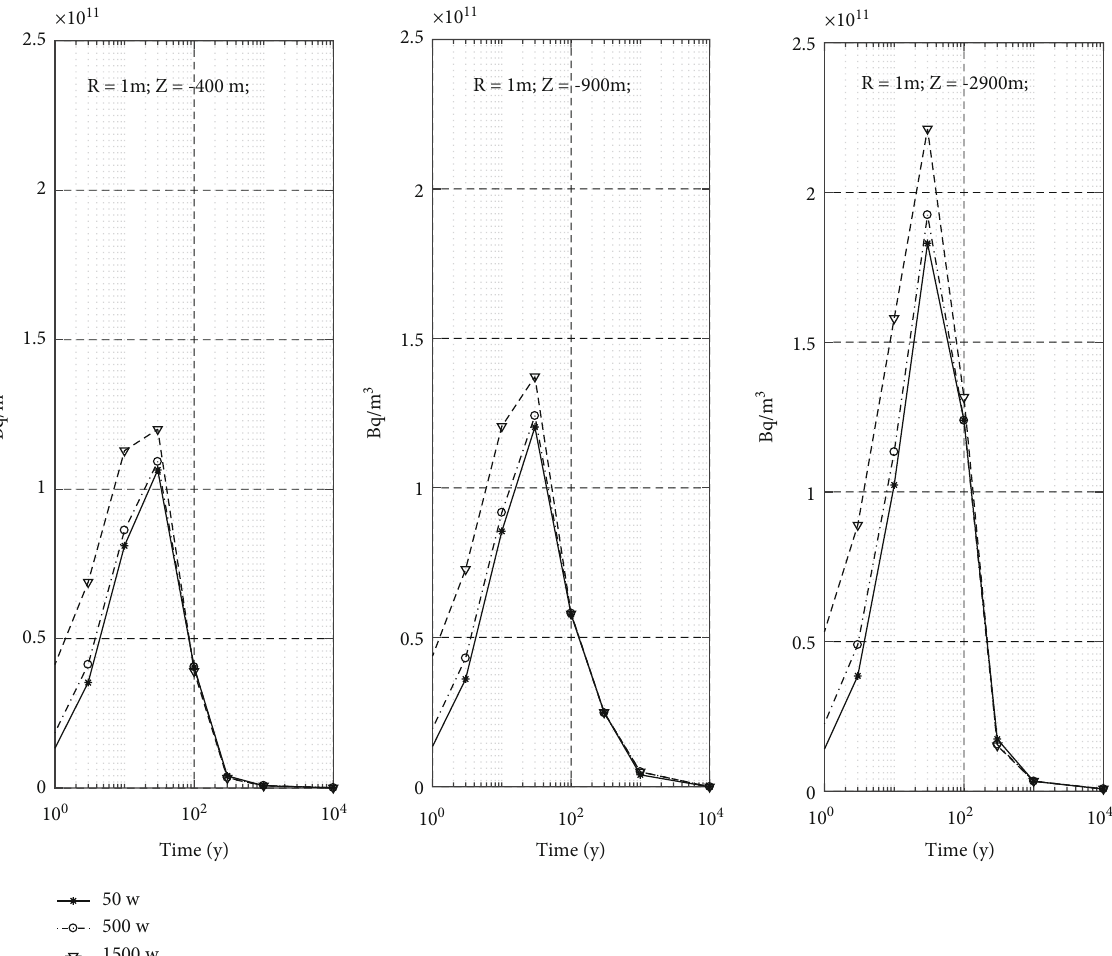
Figure 9: Total radioactivity evolution of all fi ve radionuclides observed at the midpoint of the 200m waste disposal interval and at radial distance R = 1 m as function of disposal depth ( Z = − 400 m , -900 m, and -2900 m) and heat output (50 W, 500W, and 1500